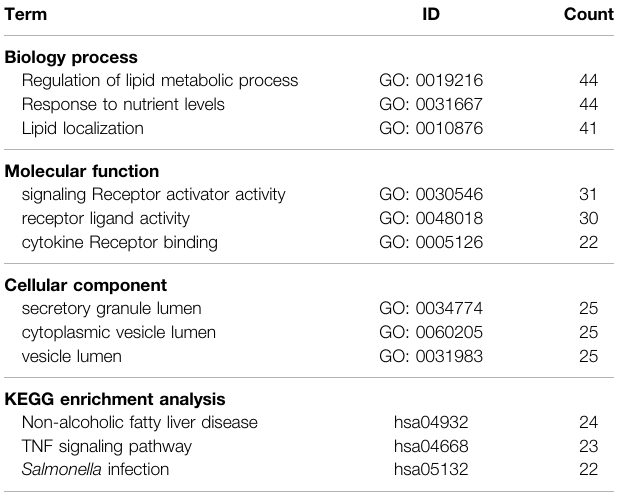
TABLE 2 | The results of GO and KEGG enrichment analyses.